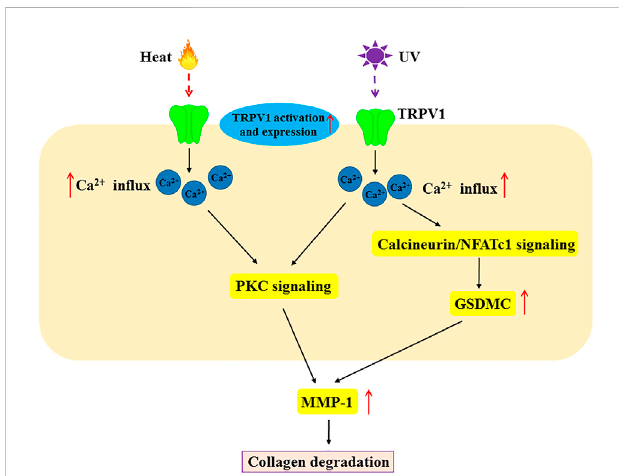
FIGURE 3 ThemolecularmechanismofTRPV1inheatandUV-inducedMMP- 1 expression in skin aging. Heat and UV light not only activate TRPV1 but also increase its expression. Heat and UV induce MMP-1 expression via Ca 2+ in fl ux, PKC signaling and calcineurin/NFATc1 signaling. This scheme demonstrates the role of TRPV1 in skin aging by heat and UV. MMP-1, matrix metalloproteinase-1; PKC, protein Kinase C; NFATc1, nuclear factor of activated T-cells, cytoplasmic